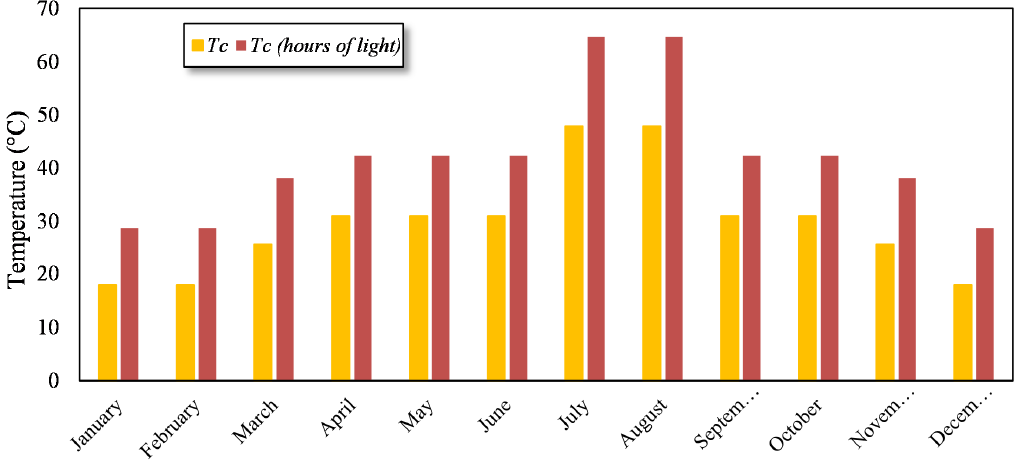
Energies 2020 , 13 , x FOR PEER REVIEW Figure 13. Monthly values of TJ cell temperature during the hours of light and all the day.